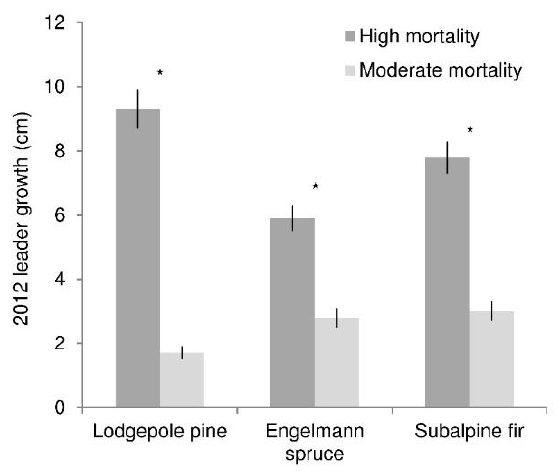
Figure 4. Average 2012 leader growth of lodgepole pine, Engelmann spruce, and subalpine fir (trees <1.4 m tall) under high and moderate levels of overstory mortality. Stars indicate significant growth differences between the mortality levels (α = 0.05). Lines show standard error of the mean.